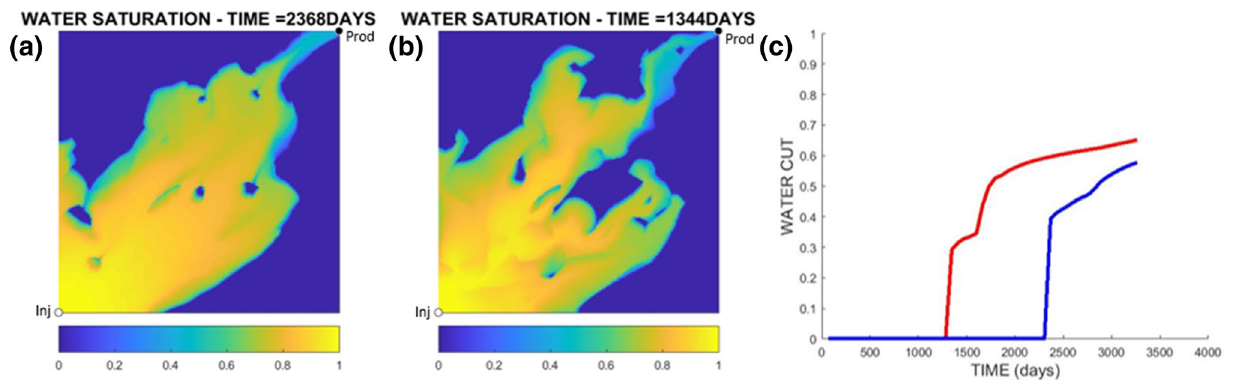
Fig. 13 a Saturation map for DP1 model at breakthrough. b Saturation map for DP2 model at breakthrough. c Water cuts simulated for DP1 (red) and DP2